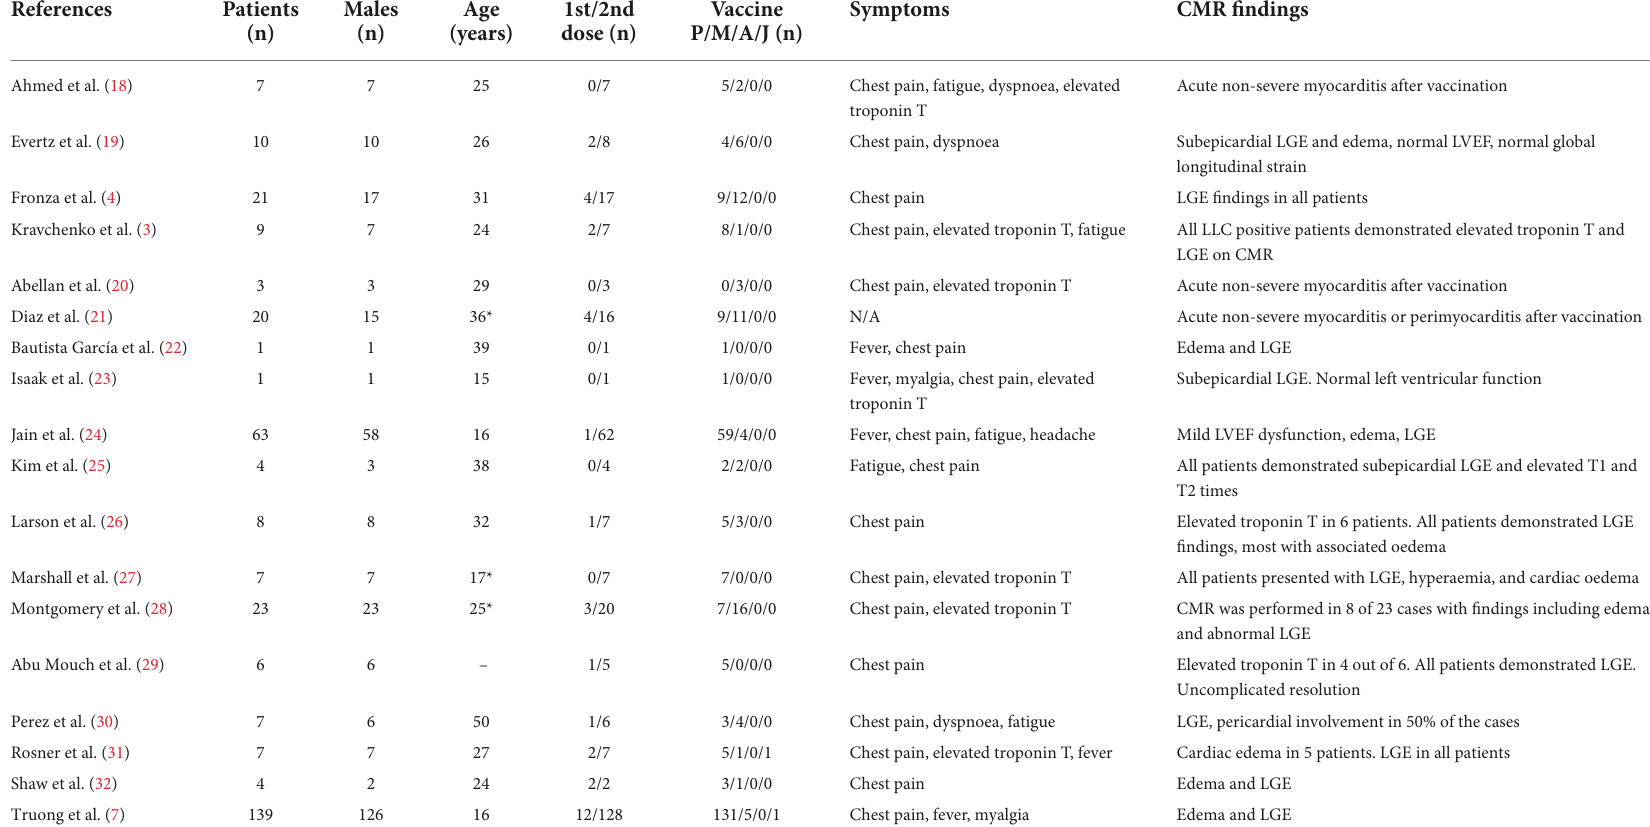
TABLE 2 An overview of current studies concerning COVID-19 vaccine associated